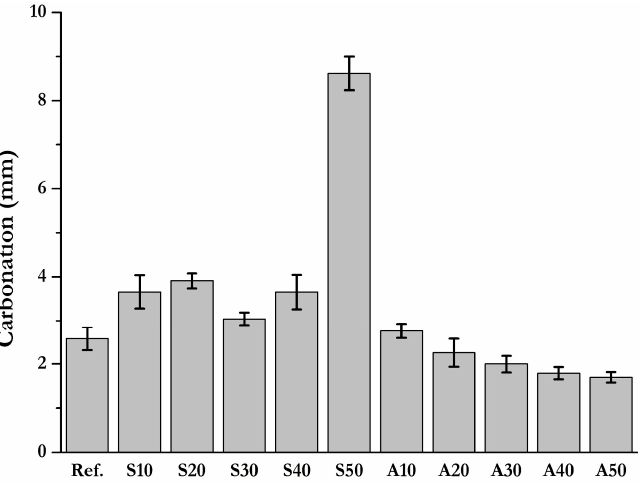
Figure 11. Carbonation depths of concrete.